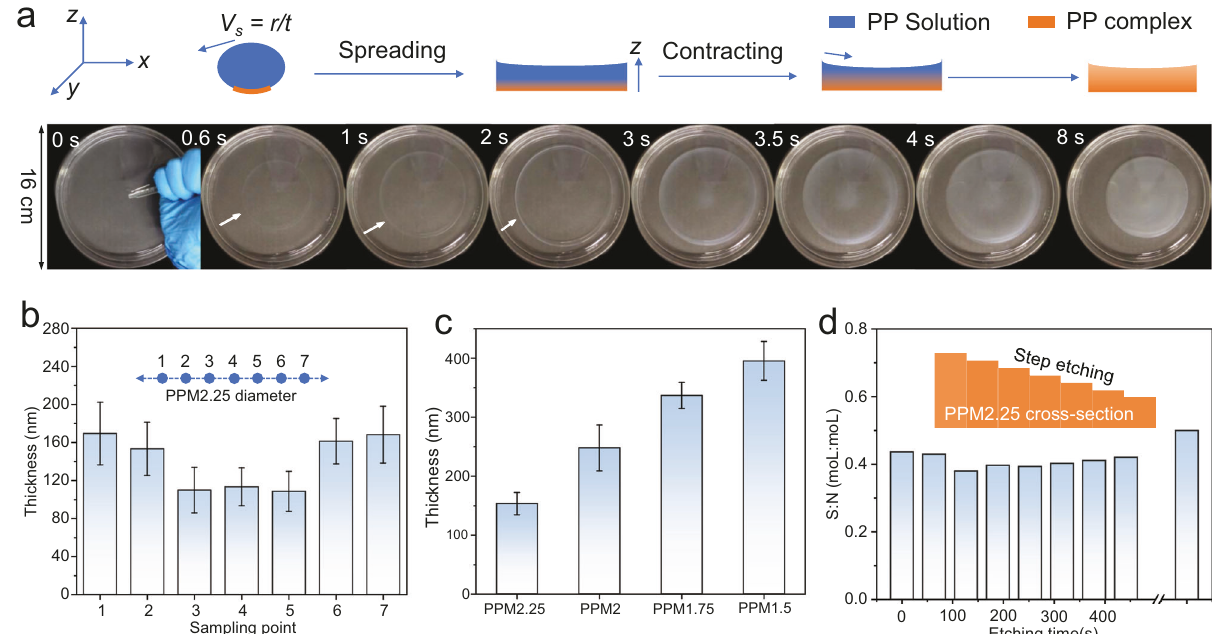
Fig. 2 Thickness and composition characterizations of PPM2.25. a Optical photographs of a PEI-PSSNa droplet spreading on pH 2.25 water; inner diameter of the glass vessel is 16 cm. Schemes are inserted to illustrate the cross-sectional changes of the droplet. b Thickness of PPM2.25 at seven different locations along the diameter direction. c Average thickness of PPMs prepared by SWOW on water with different pH. d Mole ratio of sulfur and nitrogen elements at different depth down the PPM2.25 cross-section. Error bars: standard deviation. Note: error bars in ( b , c ) are standard deviations. PP solution: PEI-PSSNa solution.